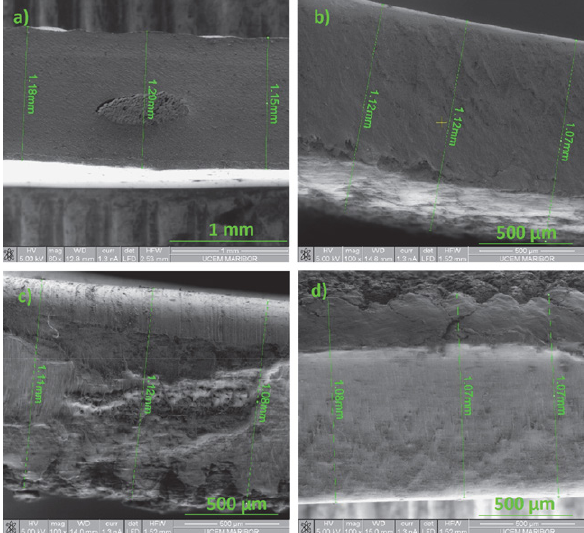
Figure 6. Microphotographs in cross section with thickness evalua- tion for new membrane (a) and aged membranes (a, b,